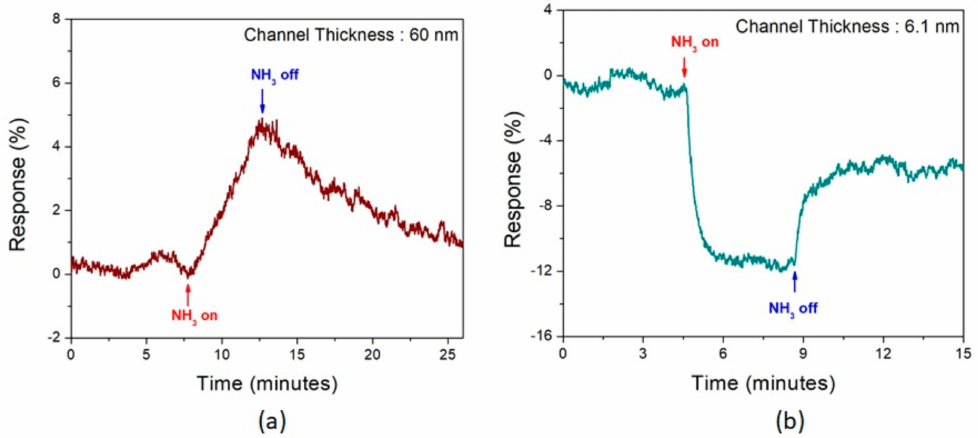
Figure 7. Response to 100 ppm NH 3 in air of ( a ) 60 nm and ( b ) 6.1 nm thick MoTe 2 devices, confirming n- and p-type conductivity, respectively. Note much faster recovery time for the thin